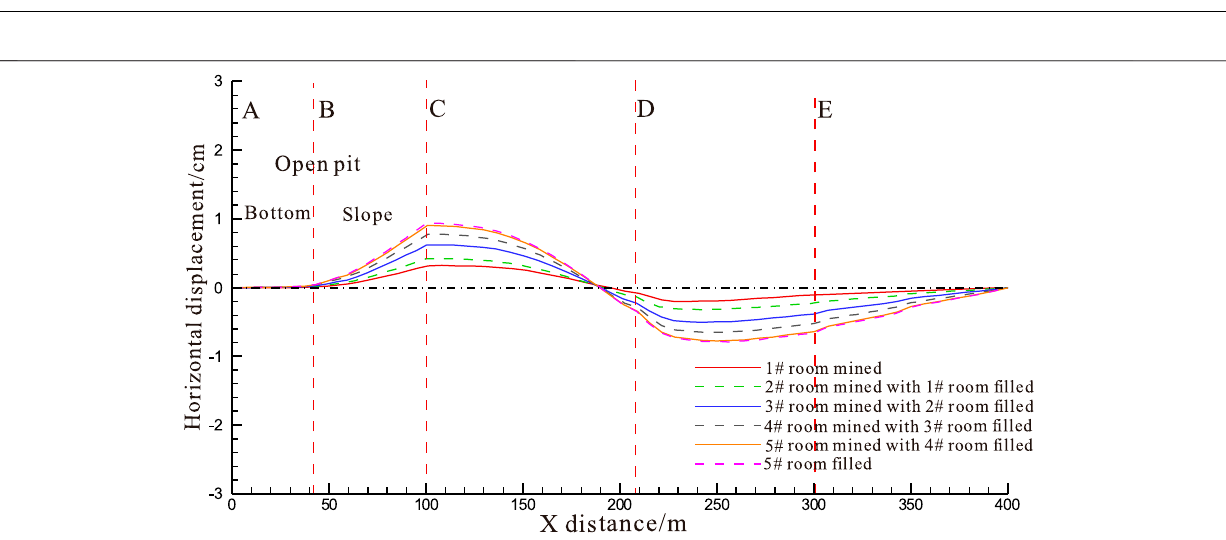
FIGURE 15 | Vertical displacement curves of the surface as pillar mining and back fi lling in sequence.